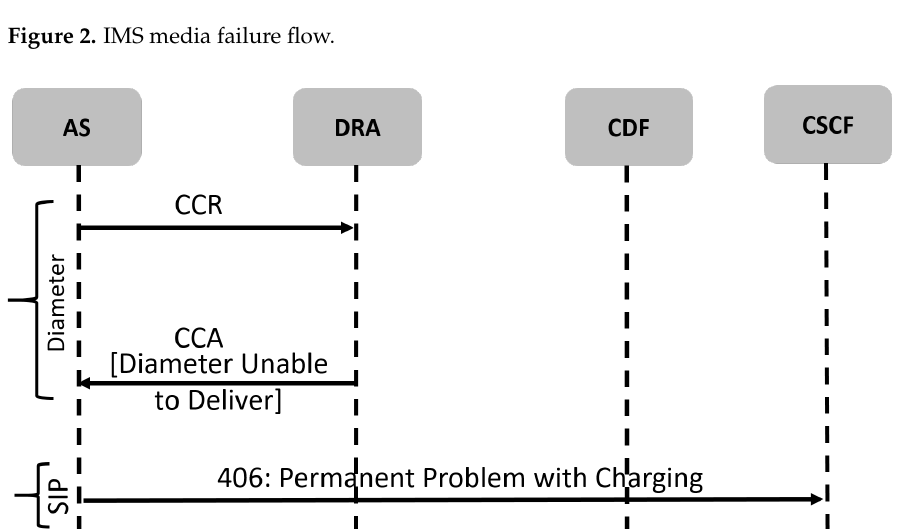
Figure 2. IMS media failure flow.